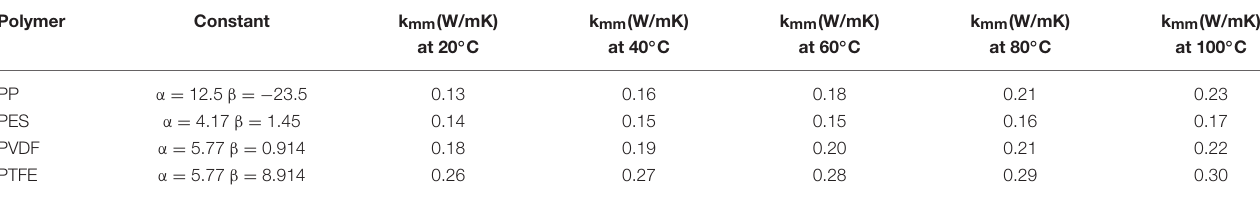
TABLE 2 | Thermal conductivity of common hydrophobic commercial membrane materials at different membrane temperatures (T m ) [Adapted from Hitsov et al. (2015)].